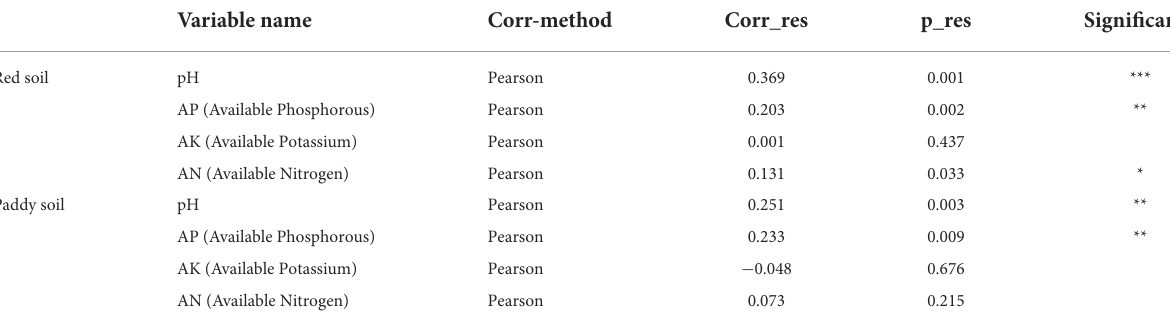
TABLE 2 Pearson correlation between the Bray–Curtis dissimilarity score and soil characteristics using the Mantel test.